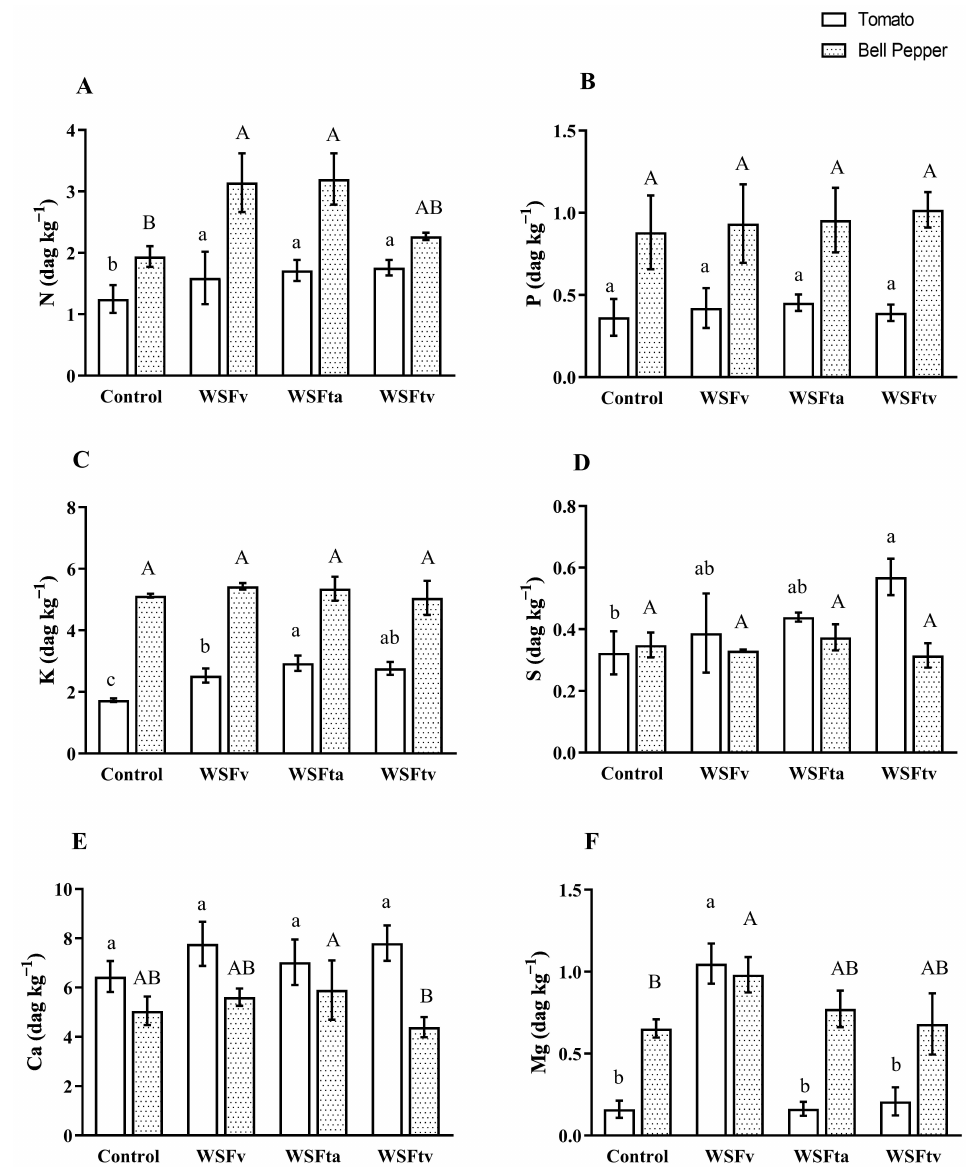
Figure 3. Macronutrient content ( A ): Nitrogen, ( B ): Phosphorus, ( C ): Potassium, ( D ): Sulfur, ( E ): Cal- cium and ( F ): Magnesium) in Meloidogyne incognita infected tomato and bell pepper plants treated with water-soluble fraction from vermicompost enriched or not with Trichoderma asperellum and T. virens . Lowercase letters and upper letters represent (LSD, p < 0.05) the effects of treatments for tomato plants and bell peppers plants, respectively. Bars represent means ± standard